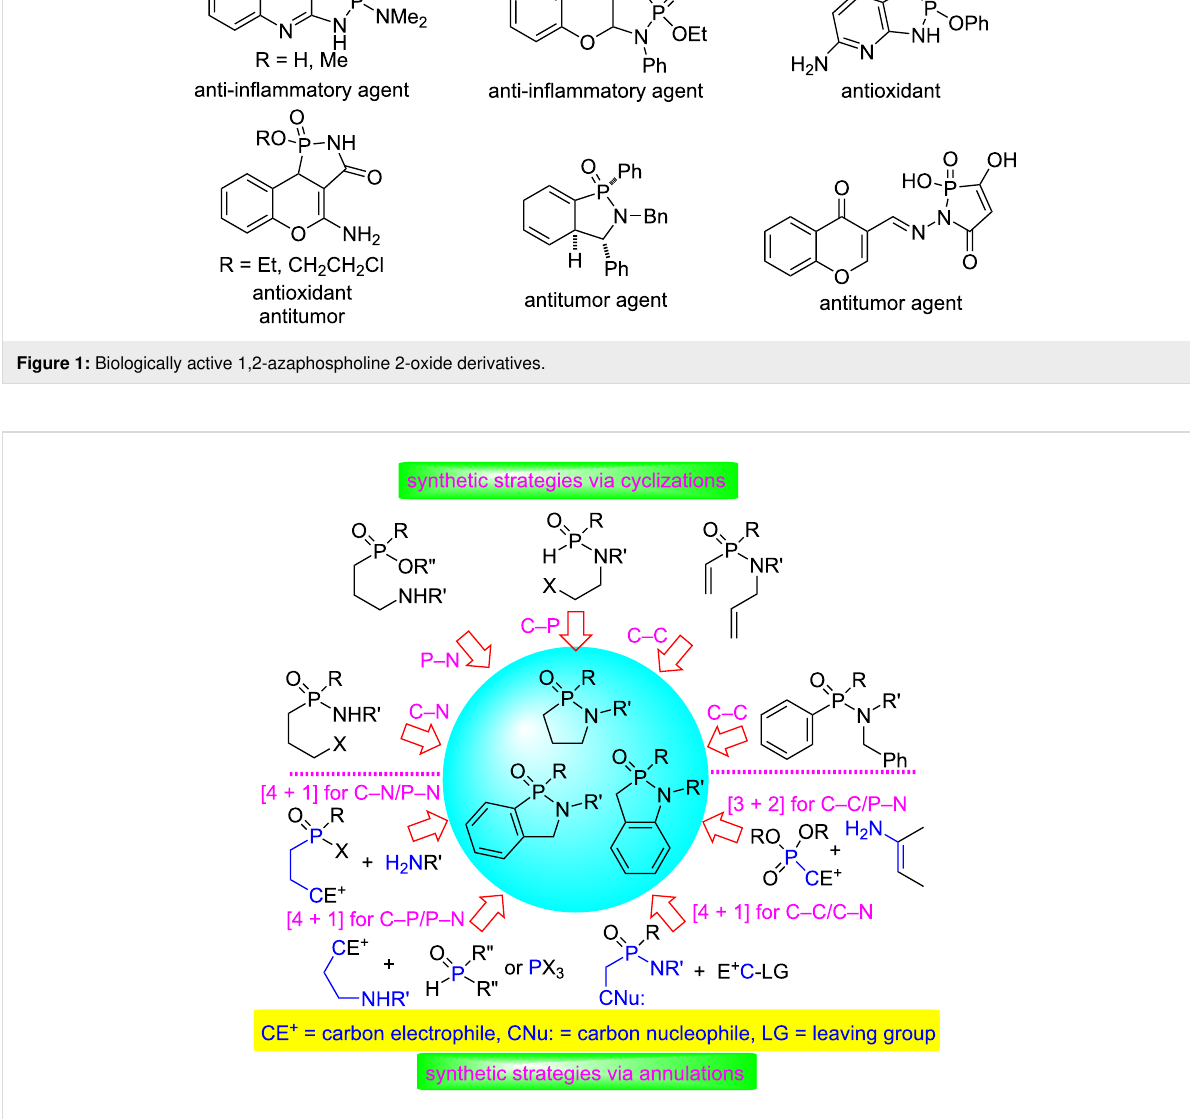
Figure 2: Diverse synthetic strategies for the preparation of 1,2-azaphospholidine and 1,2-azaphospholine 2-oxide derivatives.